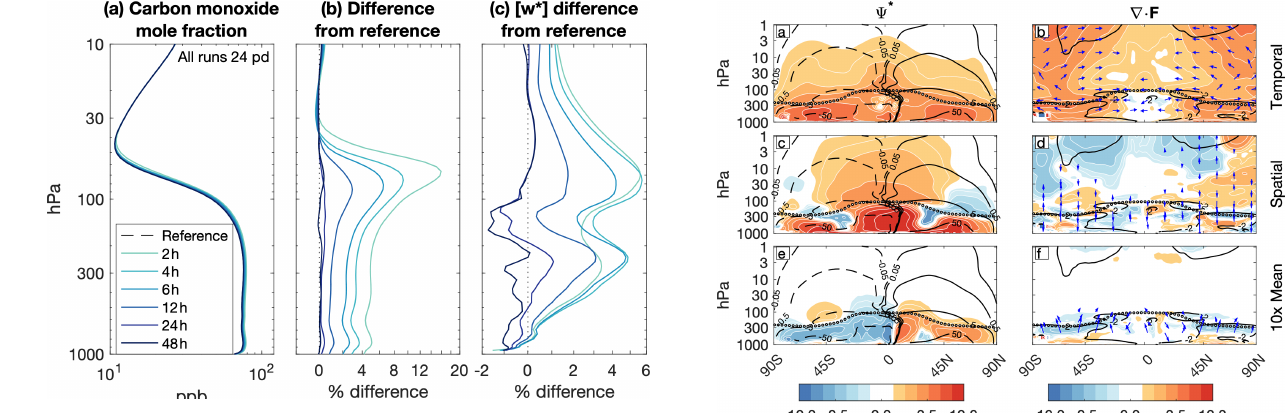
Figure 11. As in Fig. 10 but for carbon monoxide.